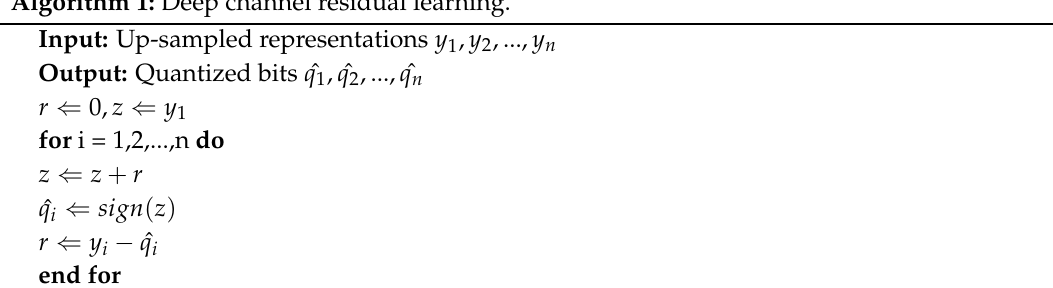
Algorithm 1: Deep channel residual